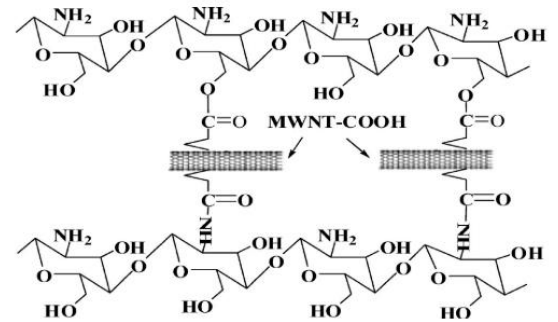
Figure 7. Interfacial linkage in carboxylic CNTs with CS. Reproduced with permission from [105], published by American Chemical Society, 2010.